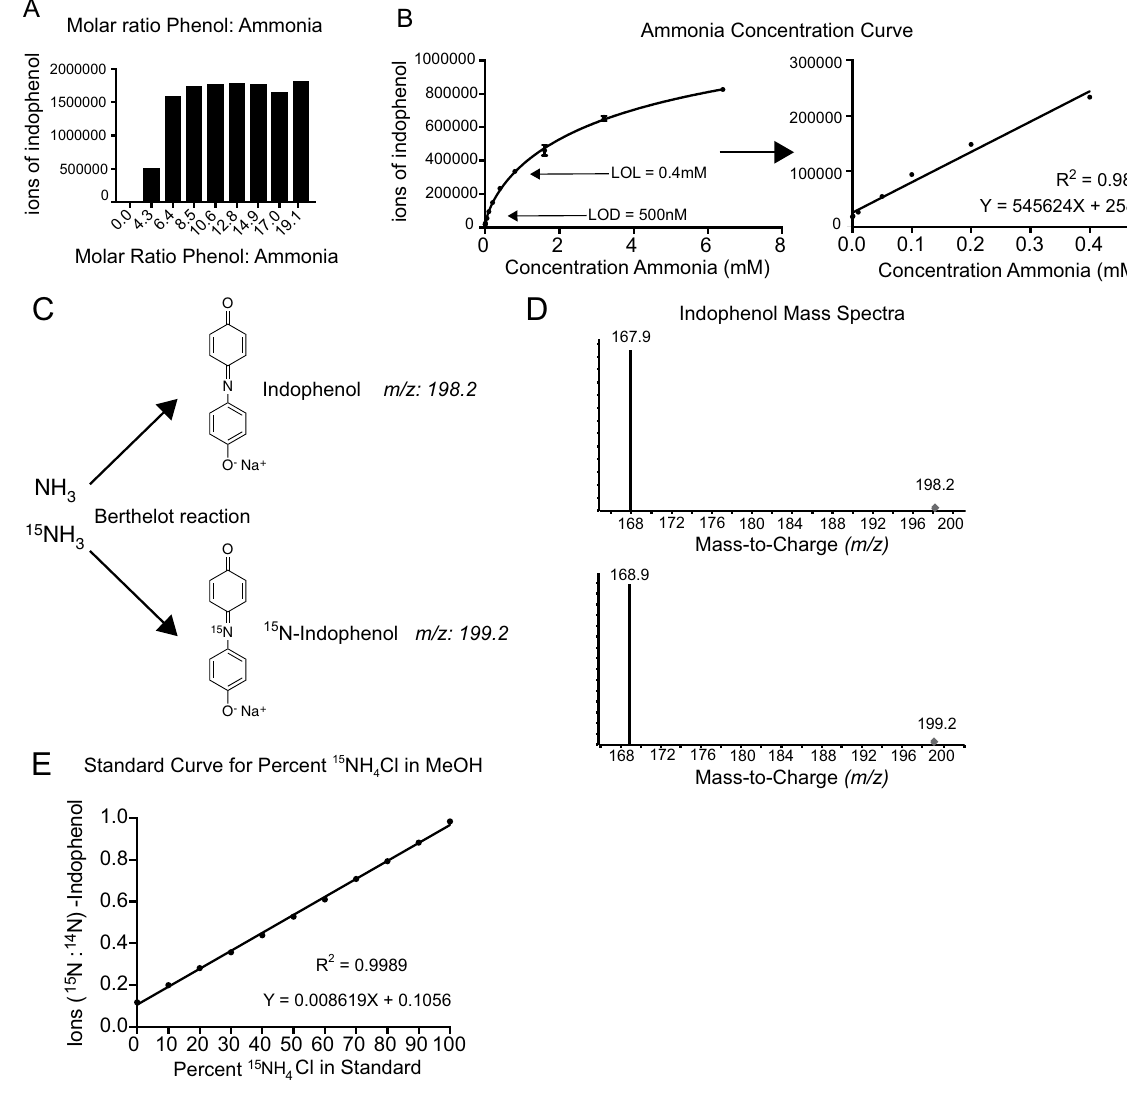
Figure 2. The Berthelot Reaction Paired with LC-MS Analysis Sensitively Measures Ammonia. ( A ) Optimization of the molar ratio of phenol to ammonia for maximal readout of indophenol after the Berthelot reaction. ( B ) Concentration curve of ammonia after the Berthelot reaction measured as indophenol with LC-MS. Ammonia standards were made in 80% methanol, n = 3 samples per concentration. LOD: Limit of detection, LOL: limit of linearity. ( C ) Schematic of the Berthelot reaction on NH 3 and 15 NH 3 , which generate indophenol and 15 N-indophenol respectively. ( D ) Mass spectra of 500 μ M NH 3 (top) and 500 μ M 15 NH 3 after the Berthelot reaction in 80% methanol. ( E ) Standard curve of percent 15 NH 3 : NH 3 in a 500 μ M ammonia solution generated in 80% methanol treated with the berthelot reaction. The resulting ratio of 15 N-indophenol: 14 N-indophenol are plotted as a function of the expected percent 15